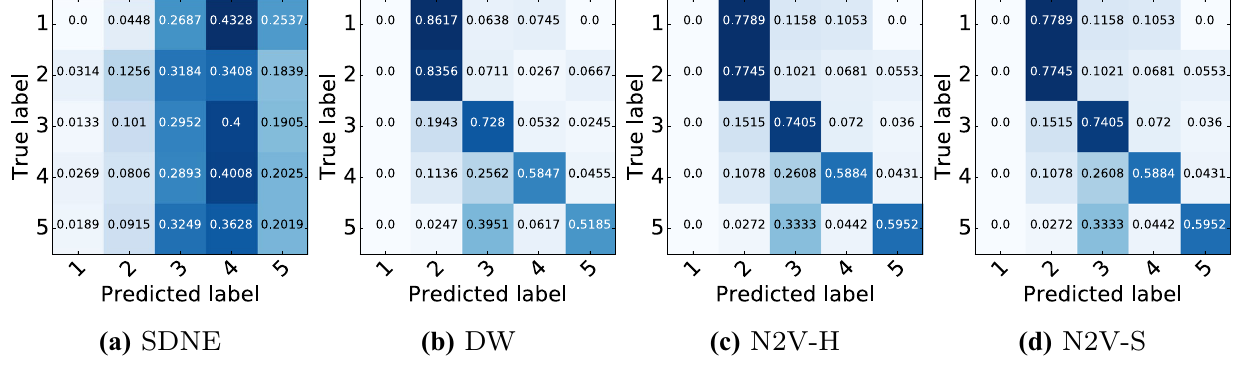
Fig. 9 Error matrices for neural network classification of eigenvector centrality (EC) for the ego-Facebook